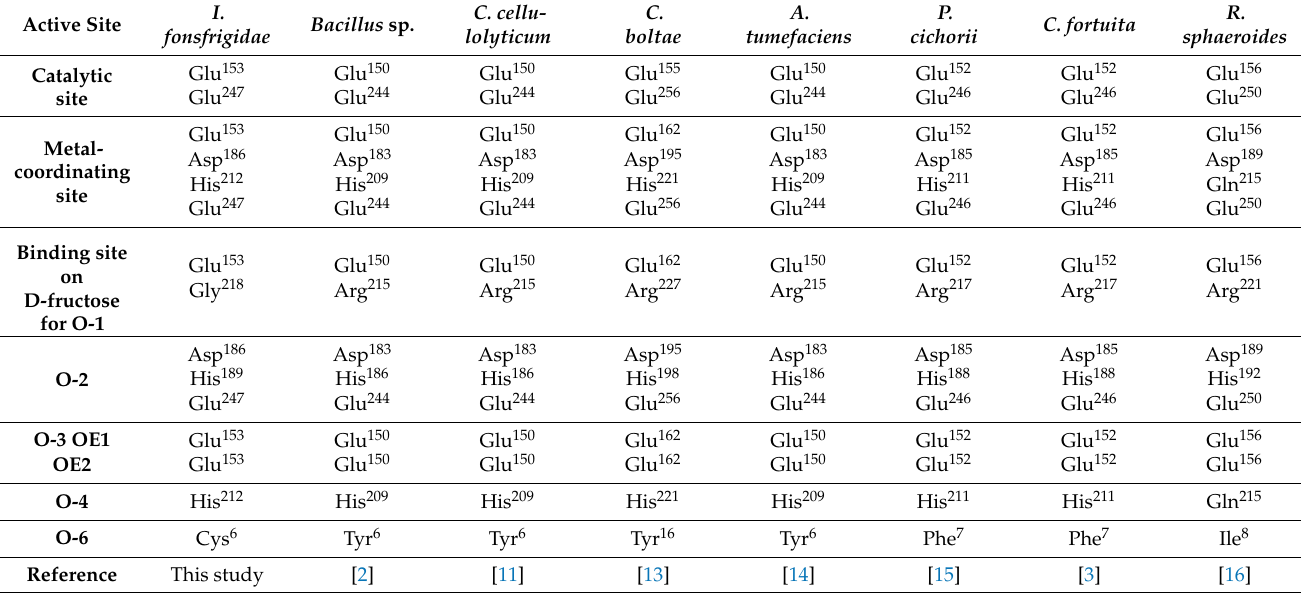
Table 2. Comparison of conserved amino acid residues in the active site of characterized ketose 3-epimerases from various microorganisms, including the catalytic site, metal-coordinating site, and substrate-binding subsites. The substrate-binding subsites revealed amino acid residues that formed hydrogen bonds with O-1 to O-6 of D-fructose compared with the C. cellulolyticum H-10 DPEase–D-fructose hydrogen bond interactions [12]. The red letters represent unique amino acids which differ from other ketose